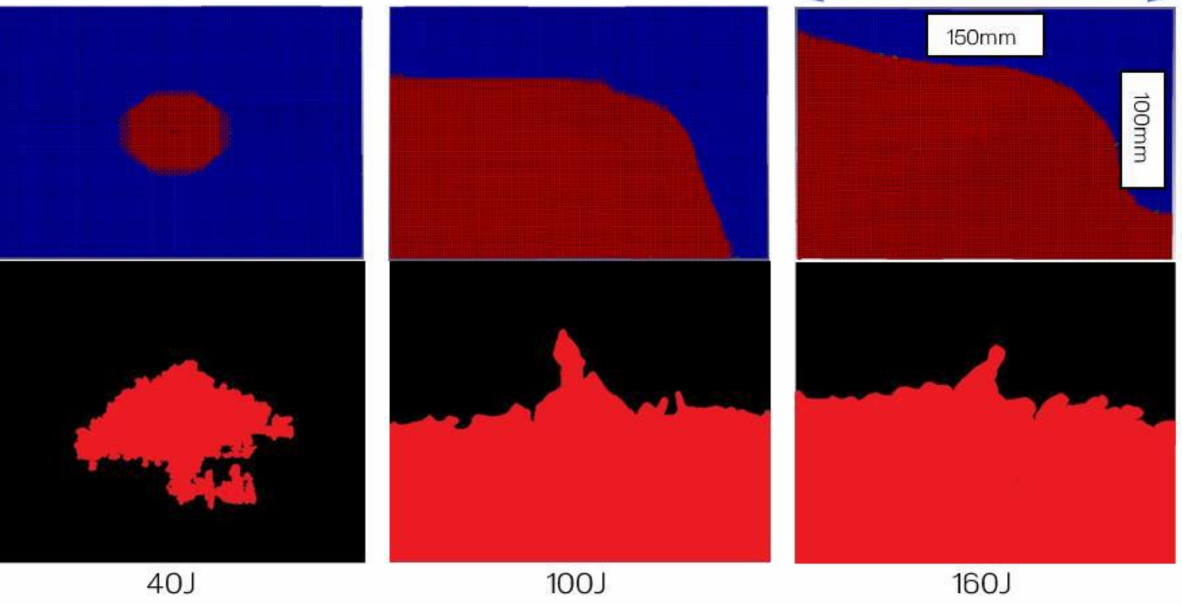
Figure 17. Damage area (envelope) computed by the numerical simulations (top three images) and damage area gathered following the experiments through X-rays for T700/PPS. Each image represents an overall panel with dimensions of 150 mm × 100